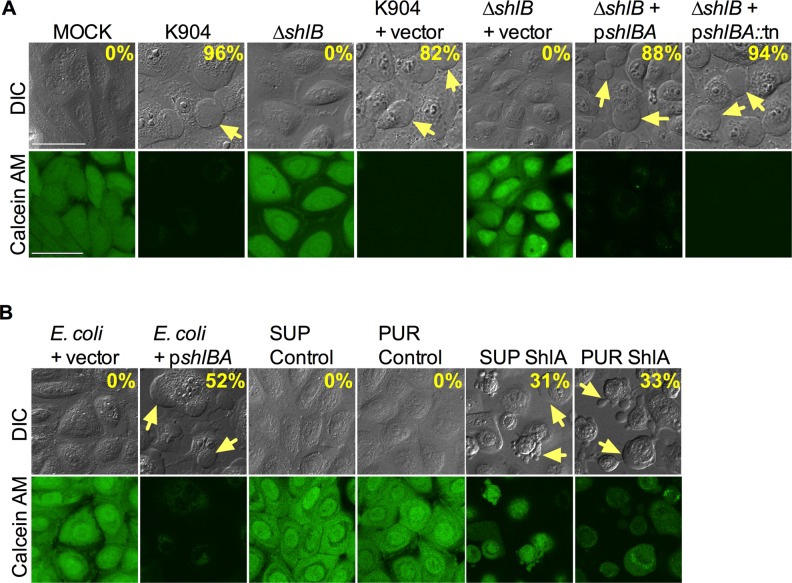
S. marcescens shlBA operon is necessary, and ShlA is sufficient, for bleb and cytotoxicity induction.Confocal micrographs of HCLE cells imaged with differential interference contrast (DIC) and calcein AM viability stain. Yellow arrows indicate blebs extending from corneal cells. The percent of bleb positive cells induced by the indicated treatment are shown. (A) Confocal micrographs of HCLE cells with S. marcescens strain K904 and mutant strains (MOI = 50, 2 h incubation). Vector = pMQ125 or pMQ131; pshlBA = pMQ541; pshlBA::tn = pMQ591. (B) Microscopic evaluation of HCLE cells exposed to E. coli (Top10) with a vector (pMQ175) or shlBA expressing plasmid (pMQ492) at MOI = 50 for 2 h. Cells were alternatively exposed for 3 h to sterile-filtered supernatants from E. coli with the pMQ175 (SUP Control) or pMQ492 (SUP ShlA) plasmids, or partially purified ShlA-containing supernatant fractions from E. coli with the vector negative control (PUR Control) or with pMQ492 (PUR ShlA). Vector = pMQ125; pshlBA = pMQ492.